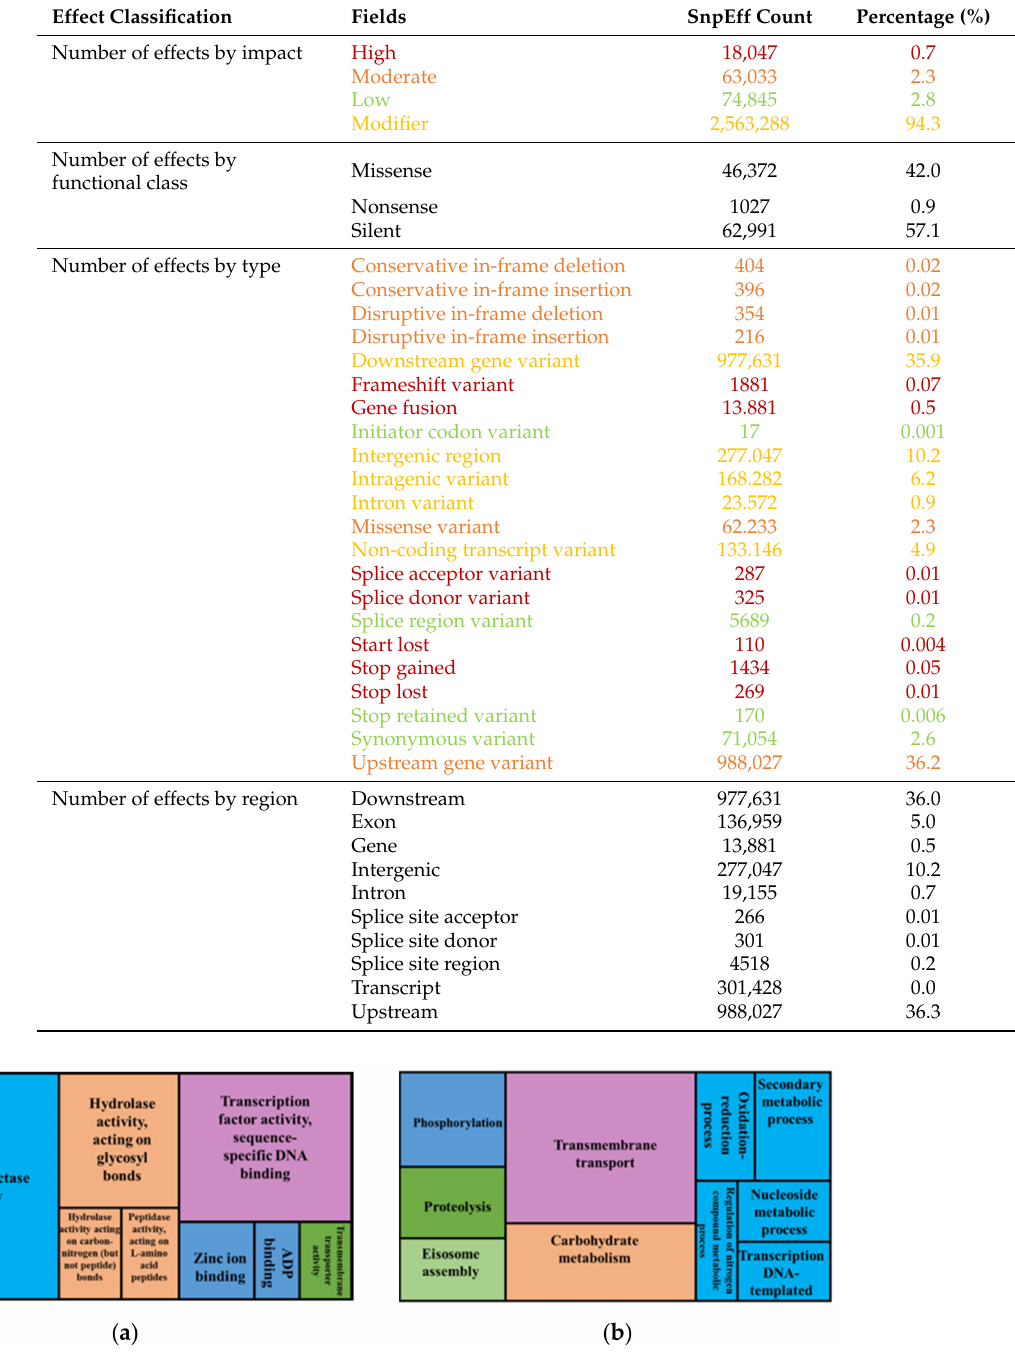
Table 6. SnpEff annotation summary of micro variants indicating number of effects (Freebayes). The impact of the different types of effects are indicated in differing colours: High impact (red), moderate impact (orange), low impact (green) and modifier effect (yellow).